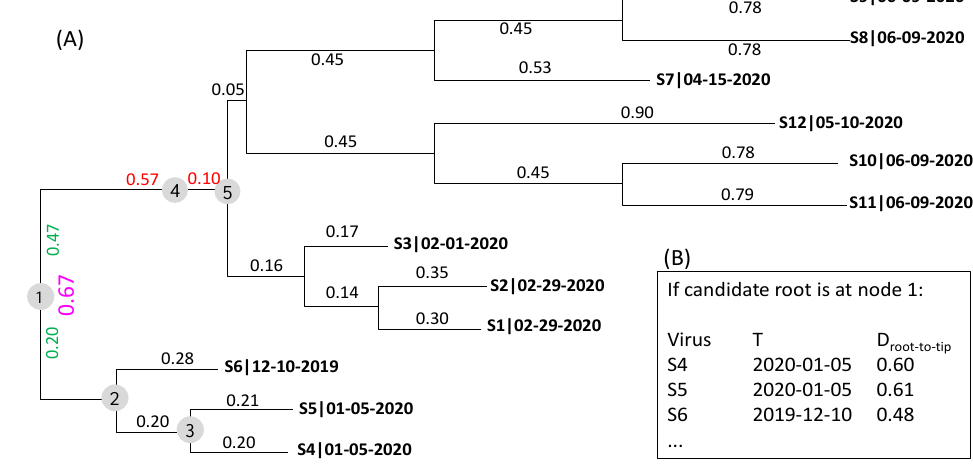
Table 1. Different root-to-tip distances ( D 1 , D 2 , D 3 , and D 4 ) when the candidate root is placed at internal nodes 1, 2, 3 and 4 in Figure 1A, respectively. T is virus collection time in the format of yyyy-mm-dd. The last two rows show (1) the Pearson correlation (r) between T and D and (2) coef- ficient of determination (R 2 ) based on 𝐷 = 𝑏 0 + 𝑏 1 𝑇 + 𝑏 2 𝑇 2 . Virus